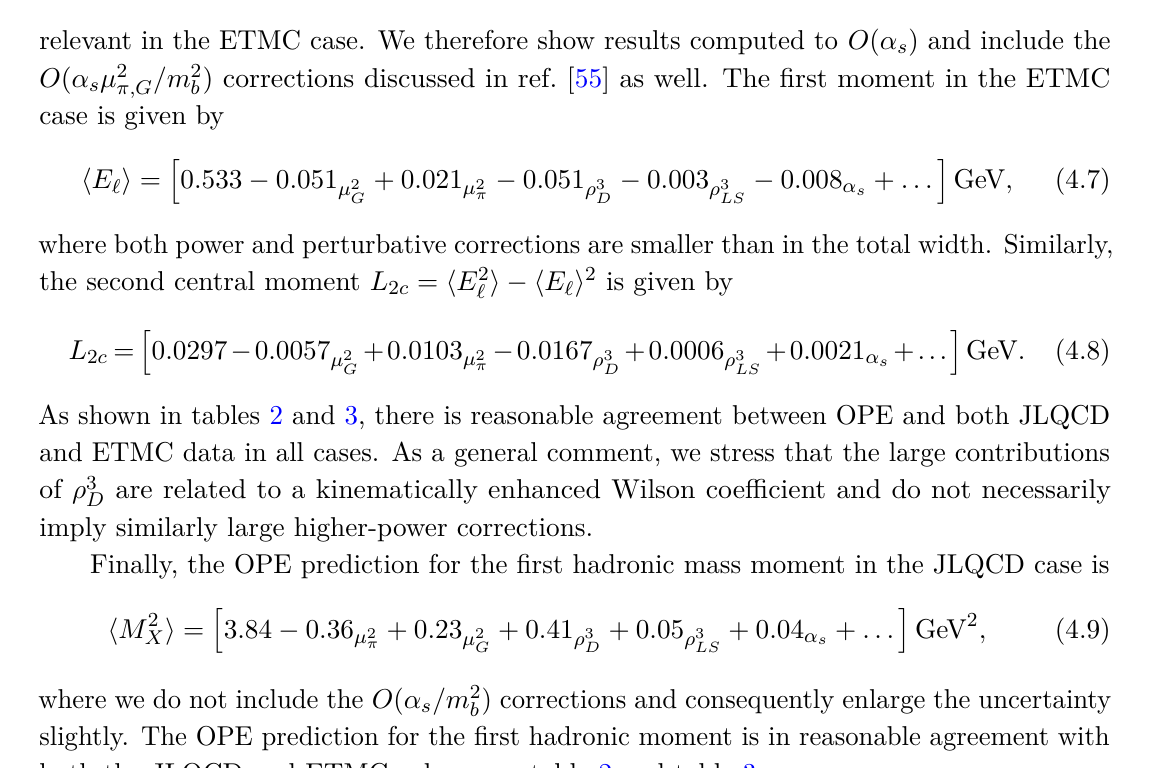
Figure 20 . Differential moment L 2 c = L 2 − L 2 comparison between OPE and ETMC